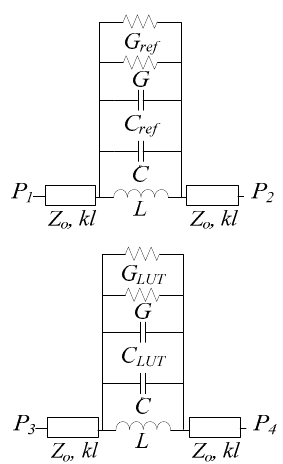
Figure 2. Equivalent circuit model of the proposed sensor.